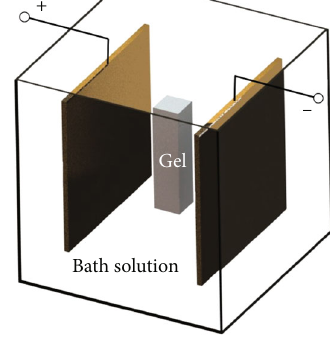
Figure 1: Ionic gel under external electric fi